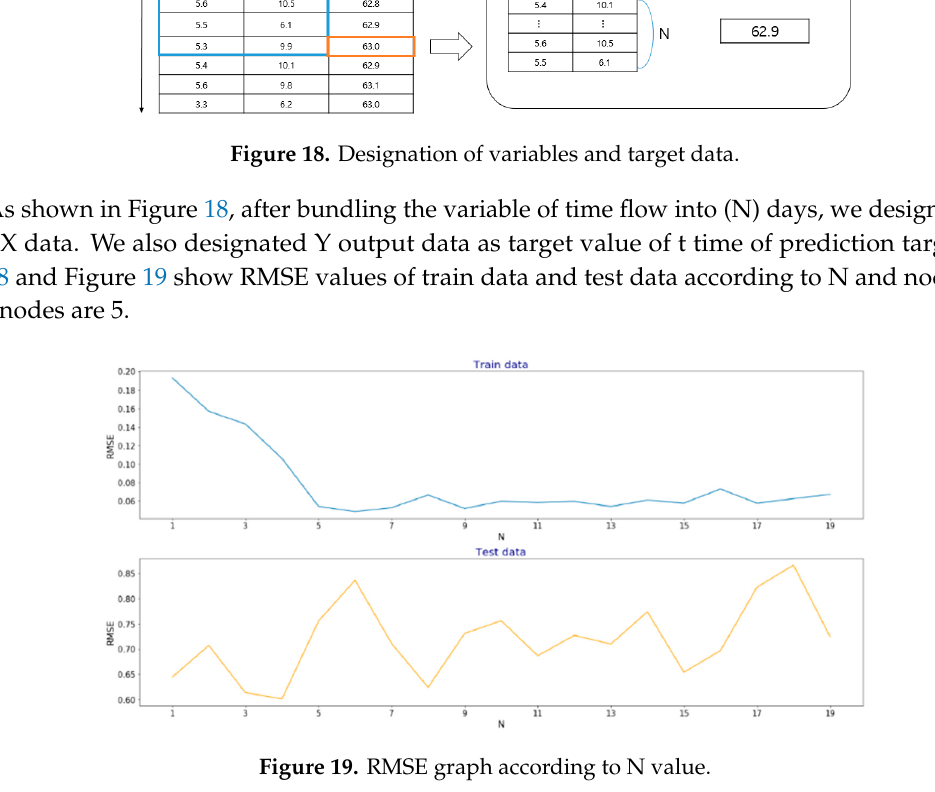
Figure 19. RMSE graph according to N value.